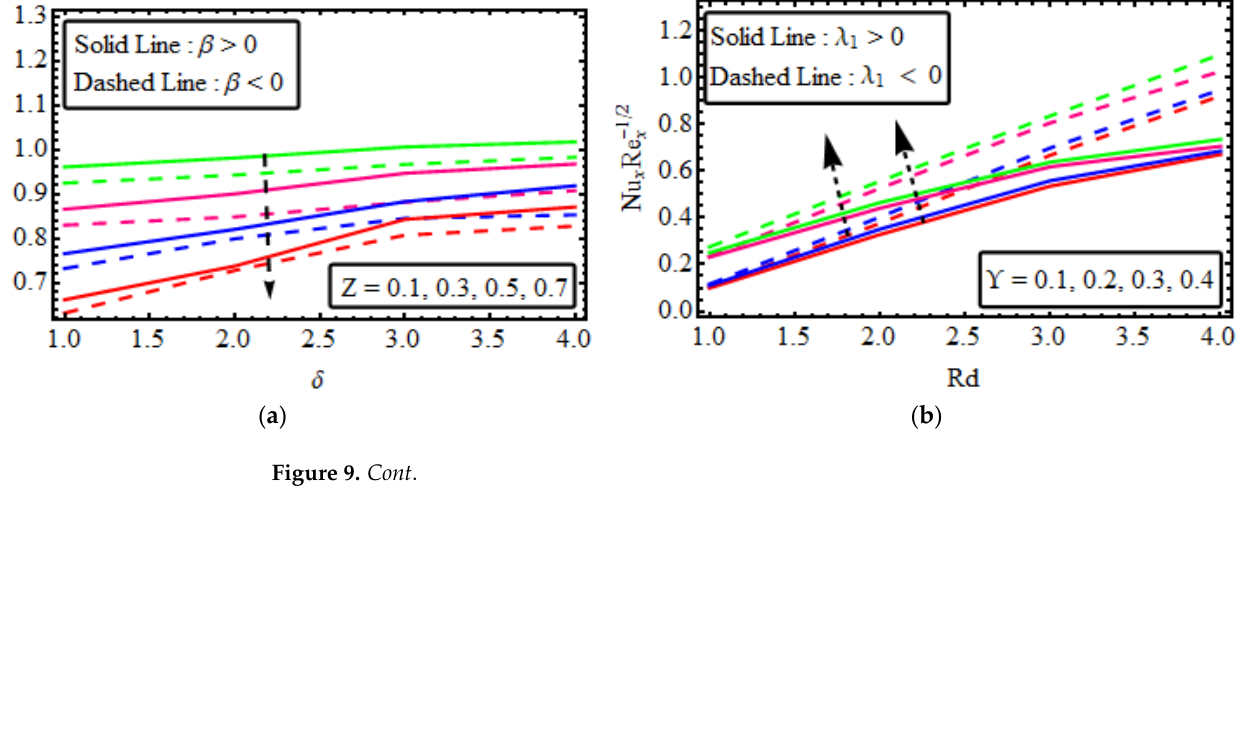
Figure 8. ( a – c ) The impact of Be numerous variables ( a ) δ ( b ) Re L ( c ) Br .